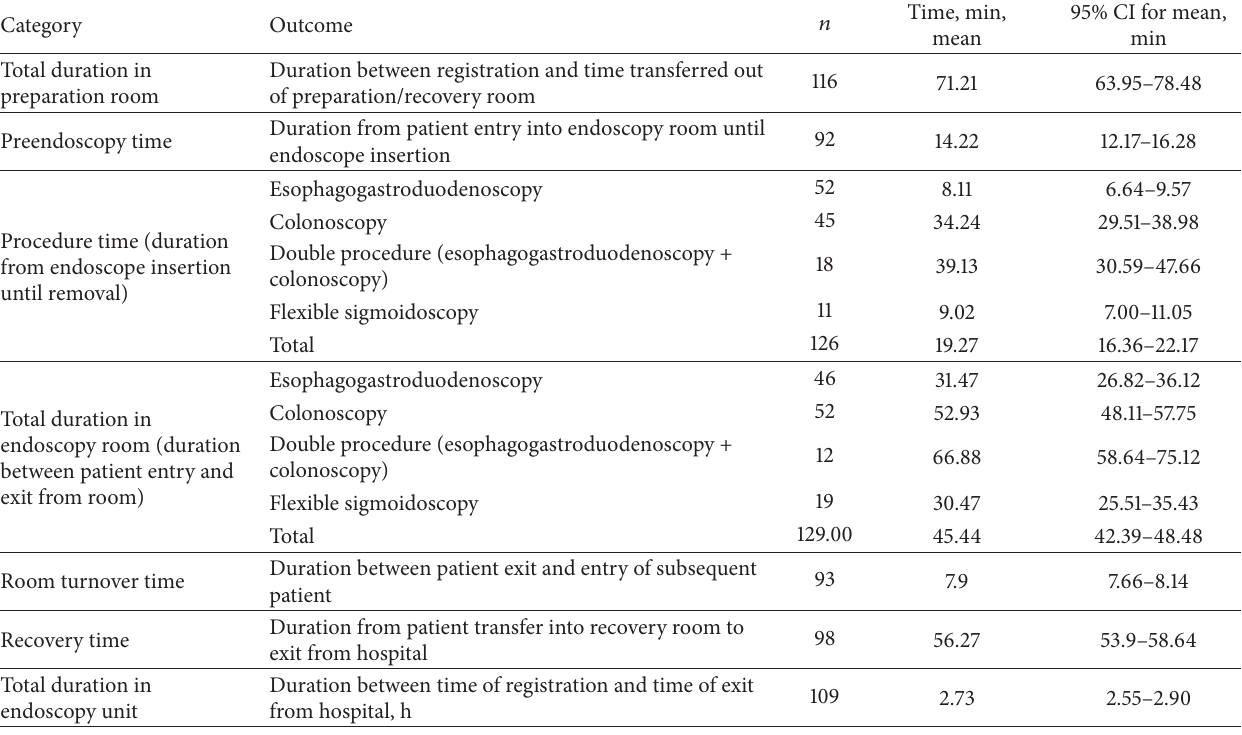
Table 2: Data regarding endoscopy workflow process measures.